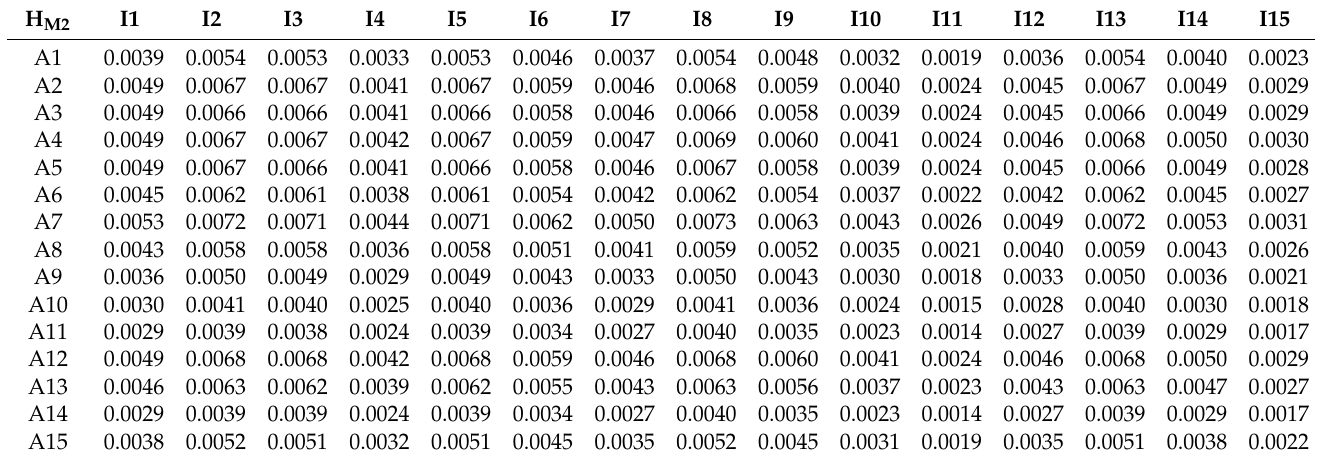
Table A4. Integrated evaluation matrix (H M2 ) after normalization (H M1 ).